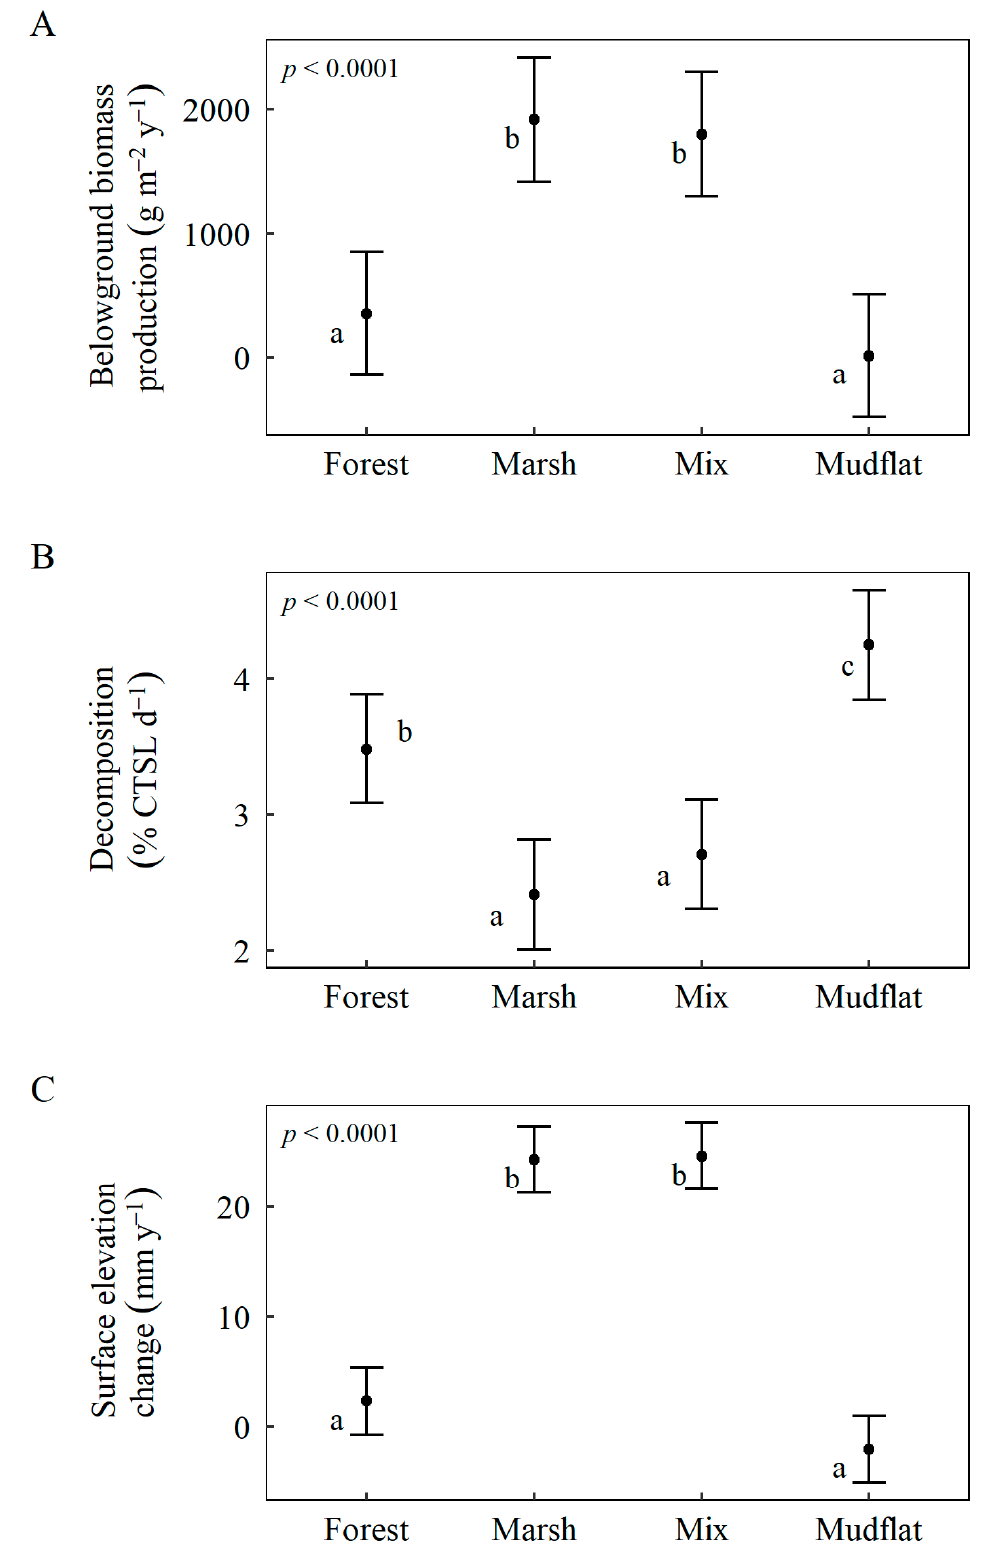
Figure 3. Variation in response variables: ( A ) belowground biomass production, ( B ) decomposition, ( C ) surface elevation change rates among communities. Response variable values are model-based estimated marginal means using Satterthwaite approximation. Brackets represent 95% confidence intervals; letters represent significant differences determined by Tukey’s ( p < 0.05) post hoc compar- isons.